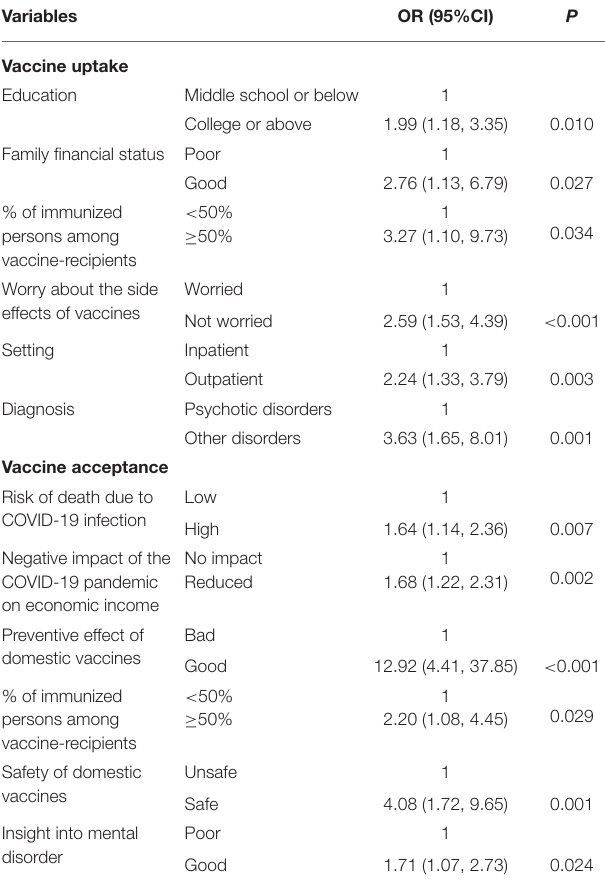
TABLE 3 | Factors associated with COVID-19 vaccine uptake and acceptance among Chinese persons with mental disorders (reference category: vaccine